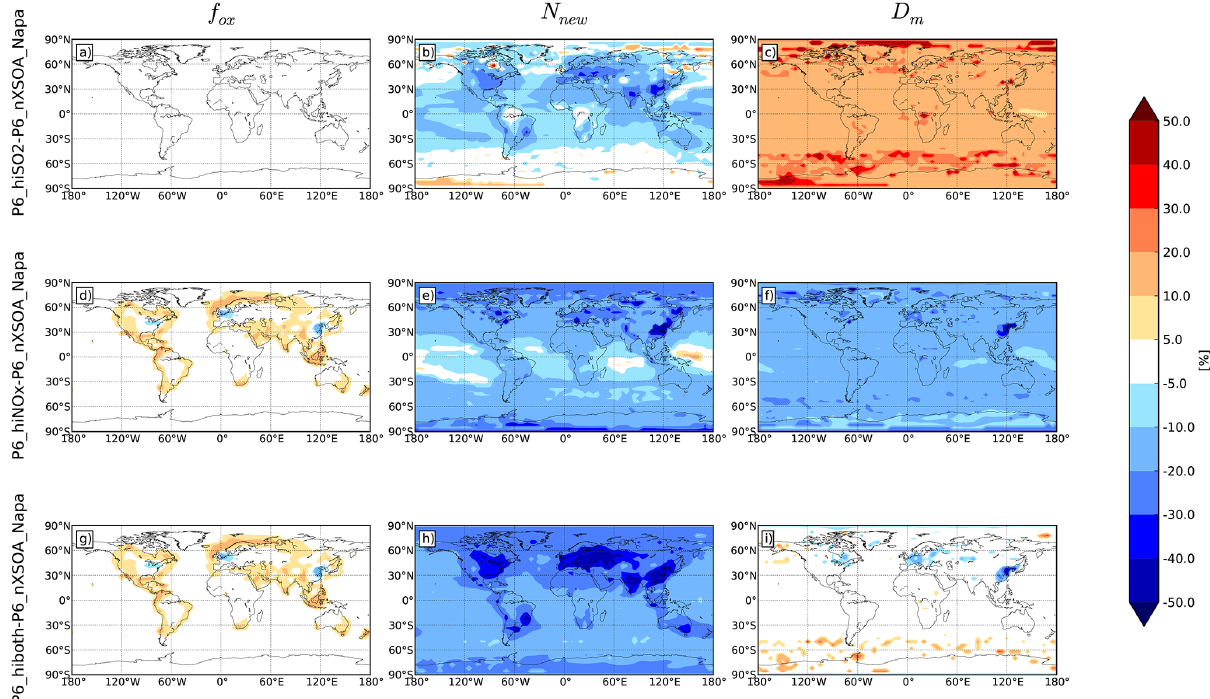
Figure 8. Relative changes in the fraction of SO 2 oxidized on the sub-grid scale ( f ox ), number of newly formed sub-grid sulphate particles per kg SO 2 emitted ( N new ), and median diameter of sub-grid sulphate particles ( D m ) from the P6_nXSOA_Napa simulation to the P6_hiSO2, P6_hiNOx, and P6_hiboth simulations, as calculated offline by the P6 Gradient